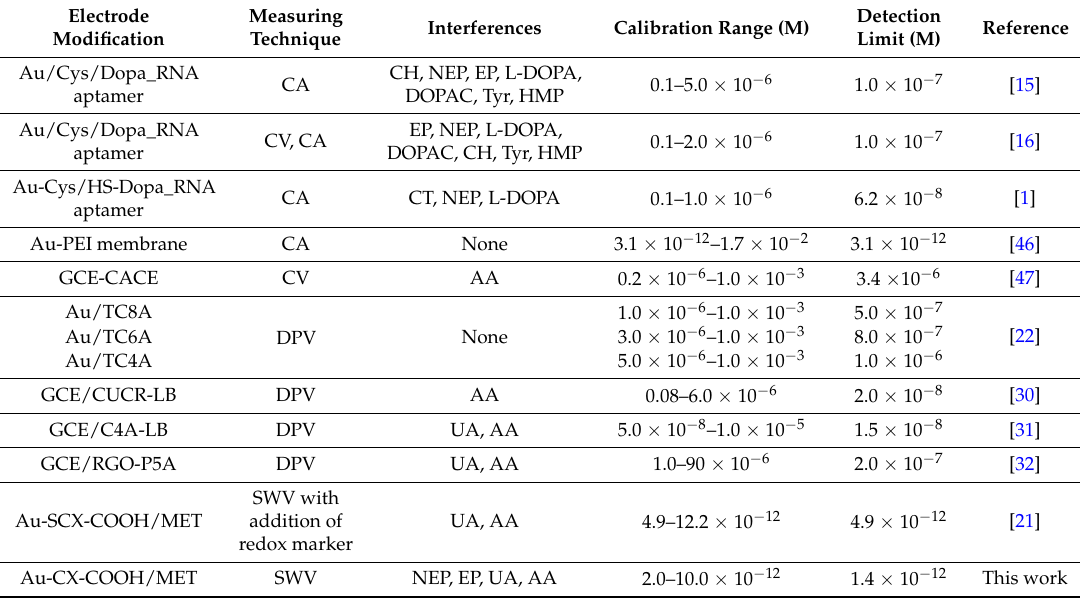
Table 1. Comparisons of analytical parameters of different electrochemical sensors applied for determination of